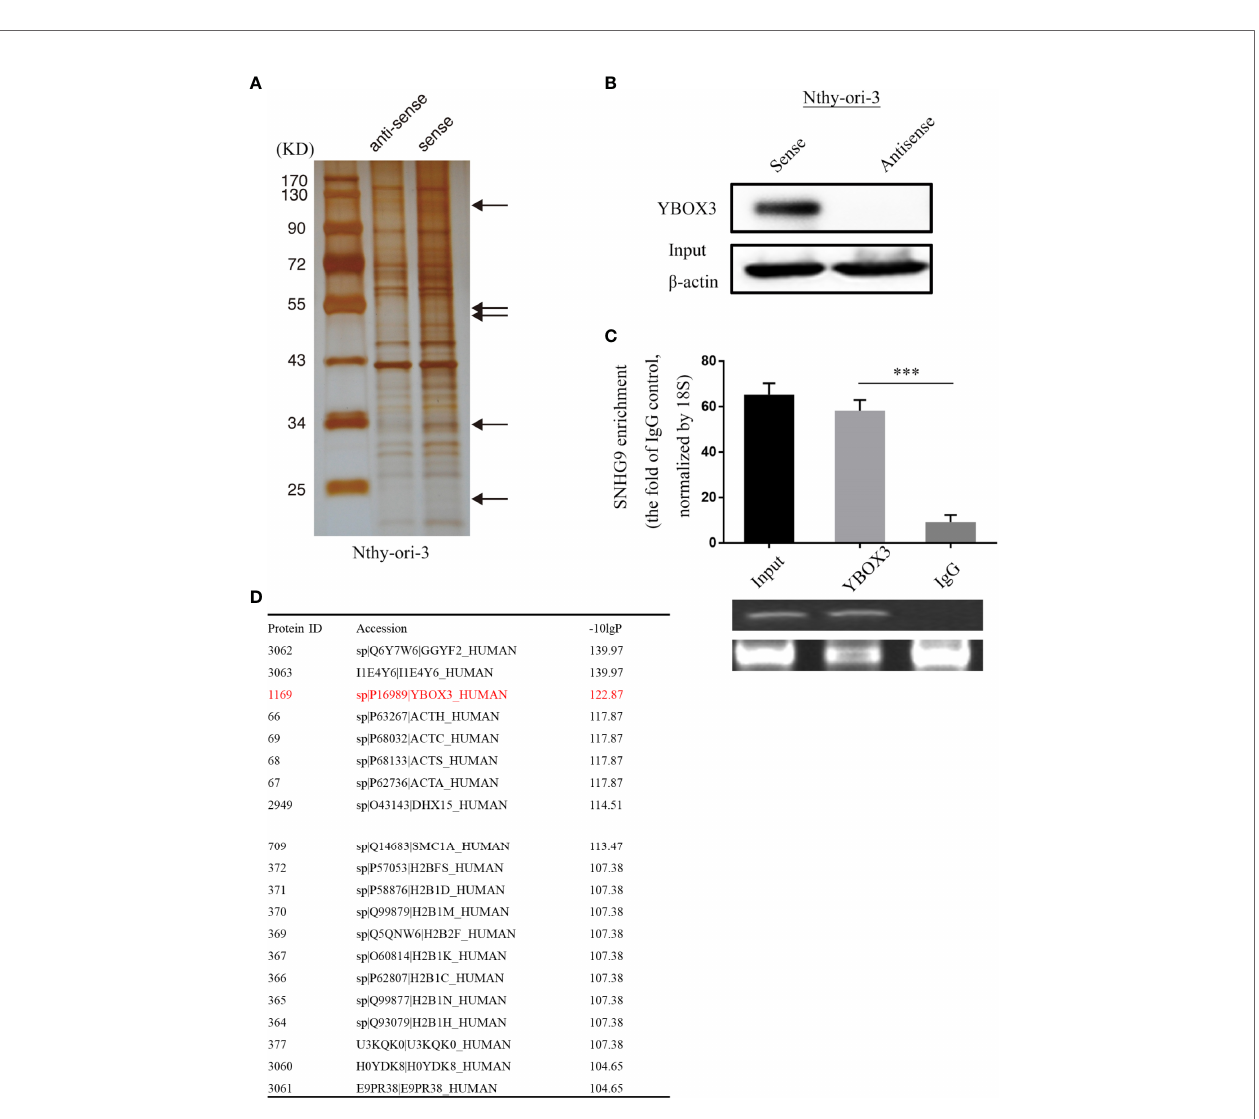
FIGURE 4 | SNHG9 interacts with YBOX3 in Nthyi-ori-3 cell. (A) An RNA-pull down assay was performed and SNHG9 related proteins were determined with SDS- PAGE and silver staining. (B) YBOX3 was pulled down by a SNHG9 sense RNA probe but not by an antisense RNA probe in Nthyi-ori-3 cell. (C) RIP assays with qPCR (top) or RT-PCR (low) showed that SNHG9 was pulled down by an anti-YBOX3 antibody in Nthyi-ori-3 cell. (D) The list of top 20 proteins with the most signi fi cant differences by mass spectrometry identi fi cation and analysis. ***P < 0.001, data were pooled from three independent experiments. SDS-PAGE, SDS- polyacrylamide gel electrophoresis; RIP, RNA immunoprecipitation analysis; qPCR, quantitative polymerase chain reaction; RT-PCR, reverse transcription polymerase chain